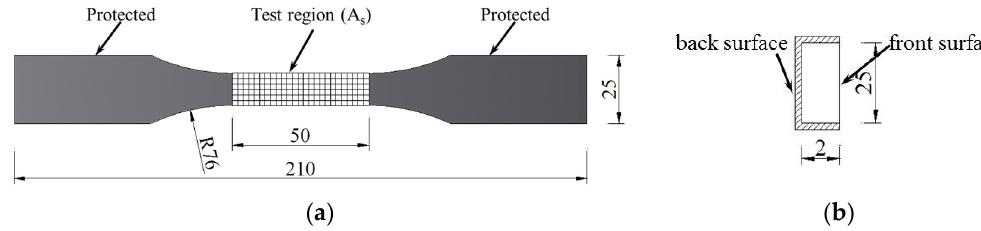
Figure 1. Geometric dimensions of carbon fiber-reinforced polymer (CFRP) specimens. ( a ) Front view; ( b ) Sectional view (unit: mm). Table 1. Chemical composition of epoxy in CFRP.